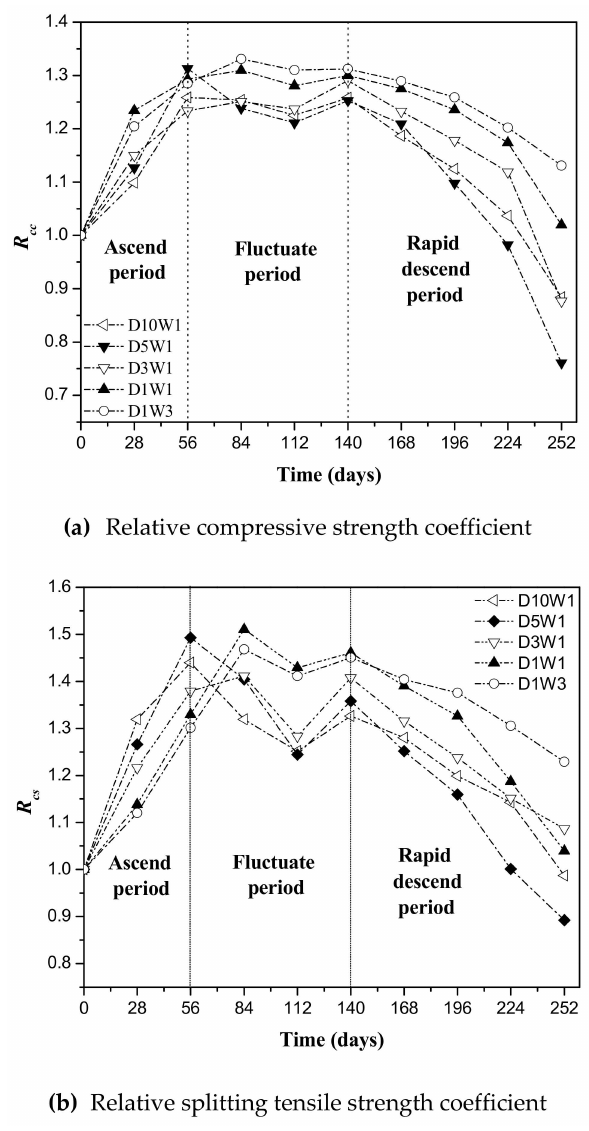
Figure 7. Mechanical properties of concrete exposed to sulfate solution under di ff erent dry–wet